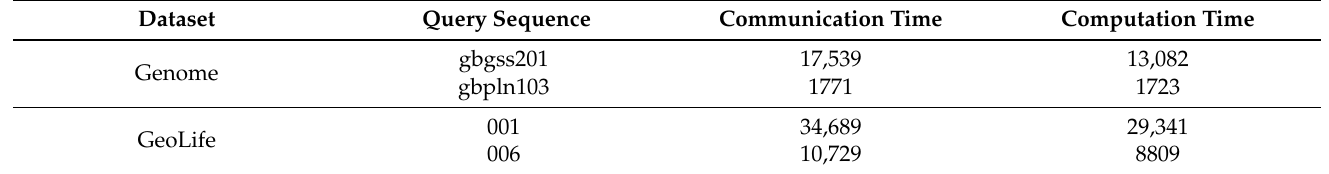
Table 1. Communication and computation time for intra-task parallelism approach.